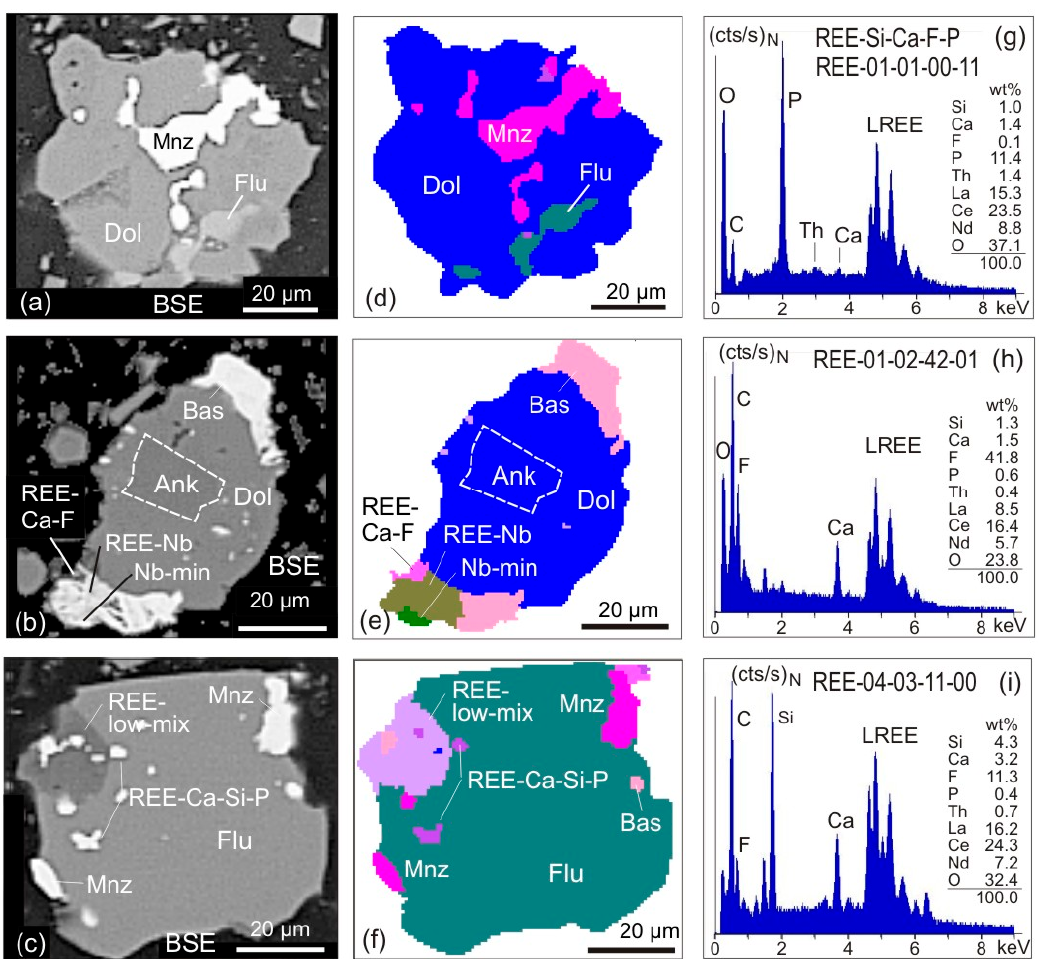
Figure 1. ( a – c ) Particles of grinded rare earth element (REE) carbonatite ore in backscattered electron images (BSE). The REE minerals monazite (Mnz), bastnaesite (Bas), and the REE-Ca-F minerals (synchysite) are in light grey to white; the REE-Nb- and Nb-bearing minerals (Nb-min) are also in light grey; the gangue minerals as ankerite (Ank), dolomite (Dol) and fluorite (Flu) are dark grey. ( d – f ) REE carbonatite ore particles after classification of automated scanning electron microscopy (SEM) measurement in the mineral liberation analysis (MLA)-XBSE routine. Classification with list of generically labelled energy-dispersive X-ray (EDX) spectra and corresponding grouping of the spectra (see text). REE minerals in the particles display only poor and partial liberation. ( g – i ) EDX spectra of some REE minerals in keV versus normalised counting rate (cts / s) N . Positions of maxima in the spectra are labelled by the corresponding elements. The generic labelling of the spectra in REE-Si-Ca-F-P is according to a quantitative EDX element analysis of the corresponding REE mineral grain, shown on the right side.